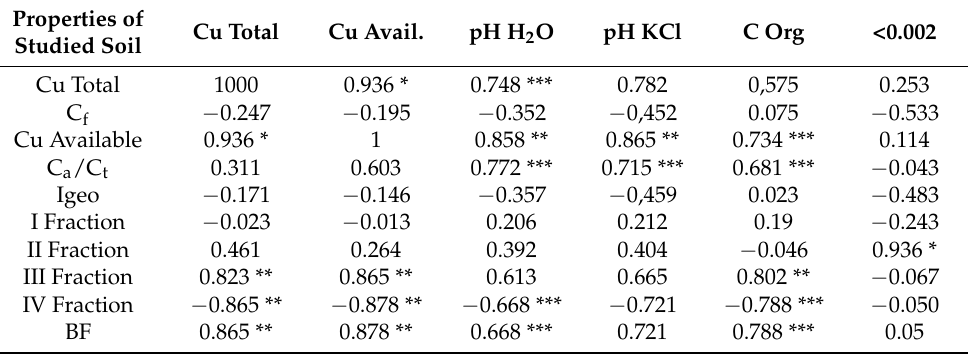
Table 2. Values of Pearson’s correlation coefficients of copper forms and indices with the physico- chemical properties of sandy